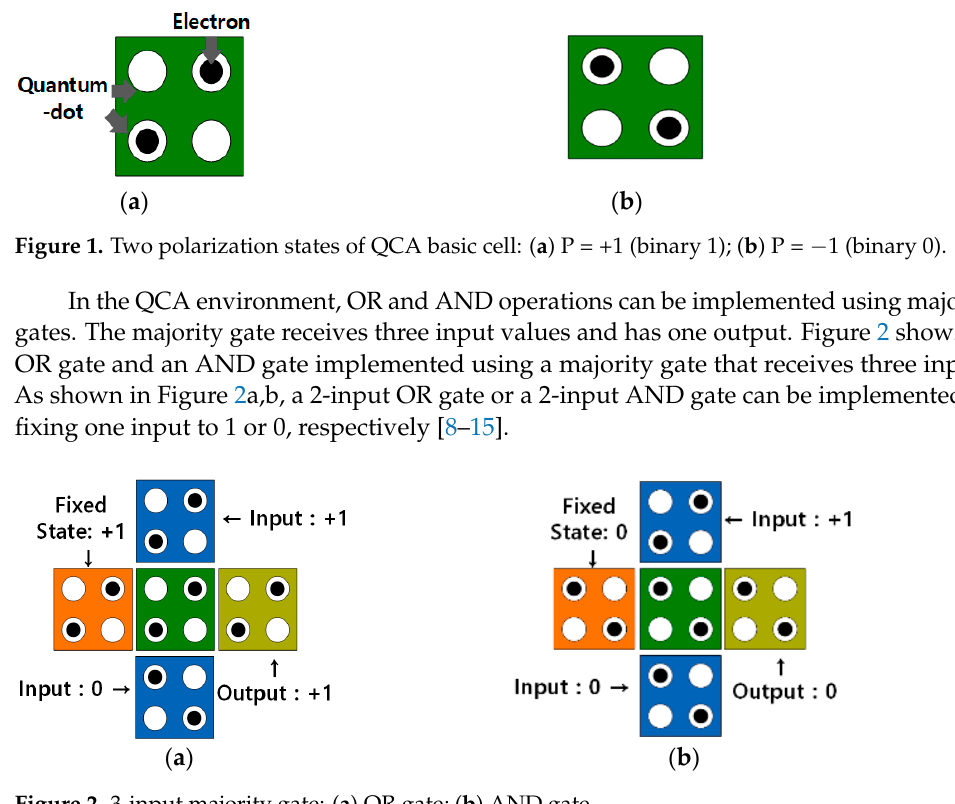
Figure 4. Multilayer based AND/OR gate: ( a ) AND gate, ( b ) OR gate. The QCA cell has four clock states as shown in Figure 5. These states are as follows: Switch is a process in which the potential of the cell gradually rises and becomes stronger, Hold is a state where the potential between quantum dots is maintained high and stabi- lized, Release is a process in which the potential is gradually decreased and weakened, and Relax is a state in which the polarization has disappeared. In QCA, these four states are used as pipeline clocks, and each pipeline clock has a phase delay of 90° from the previous clock [6,7]. Figure 5. Four states of the QCA clock . 2.2. Conventional QCA XOR Gates Figure 6 shows the previously proposed QCA XOR gates. The existing QCA XOR gates are classified into circuits designed based on majority gates and circuits designed using electronic interactions. The circuits in Figure 6a,b are designed based on the major- ity gate. Here, A and B are the input values, and OUT is the output value. The fixed values − 1.00 and 1.00 represent the binary values 0 and 1, respectively. Figure 6a is proposed by Mustafa et al. using four 3-input majority gates and one robust inverter. In Figure 6b, an XOR gate is designed using a 3-input majority gate, a weak inverter, and a 5-input major- ity gate [11,12]. Figure 6c is proposed in [13] which used a NAND gate designed by graft- ing the principle of electronic interaction of the majority gate and using it to develop an XOR gate with an excellent modularity and expandability. Figure 6d shows a gate pro- posed in [14] that performs the XOR operation with a minimum number of cells and a smaller area using electron interaction according to the cell arrangement.